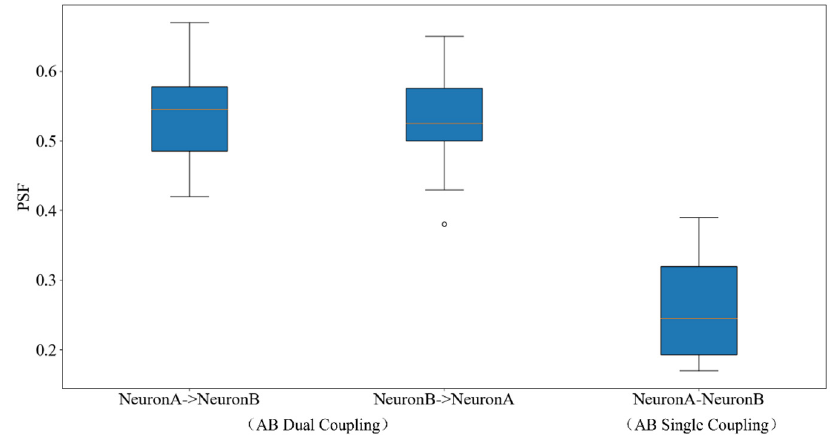
Figure 3. PSF boxplots for the different coupling states.